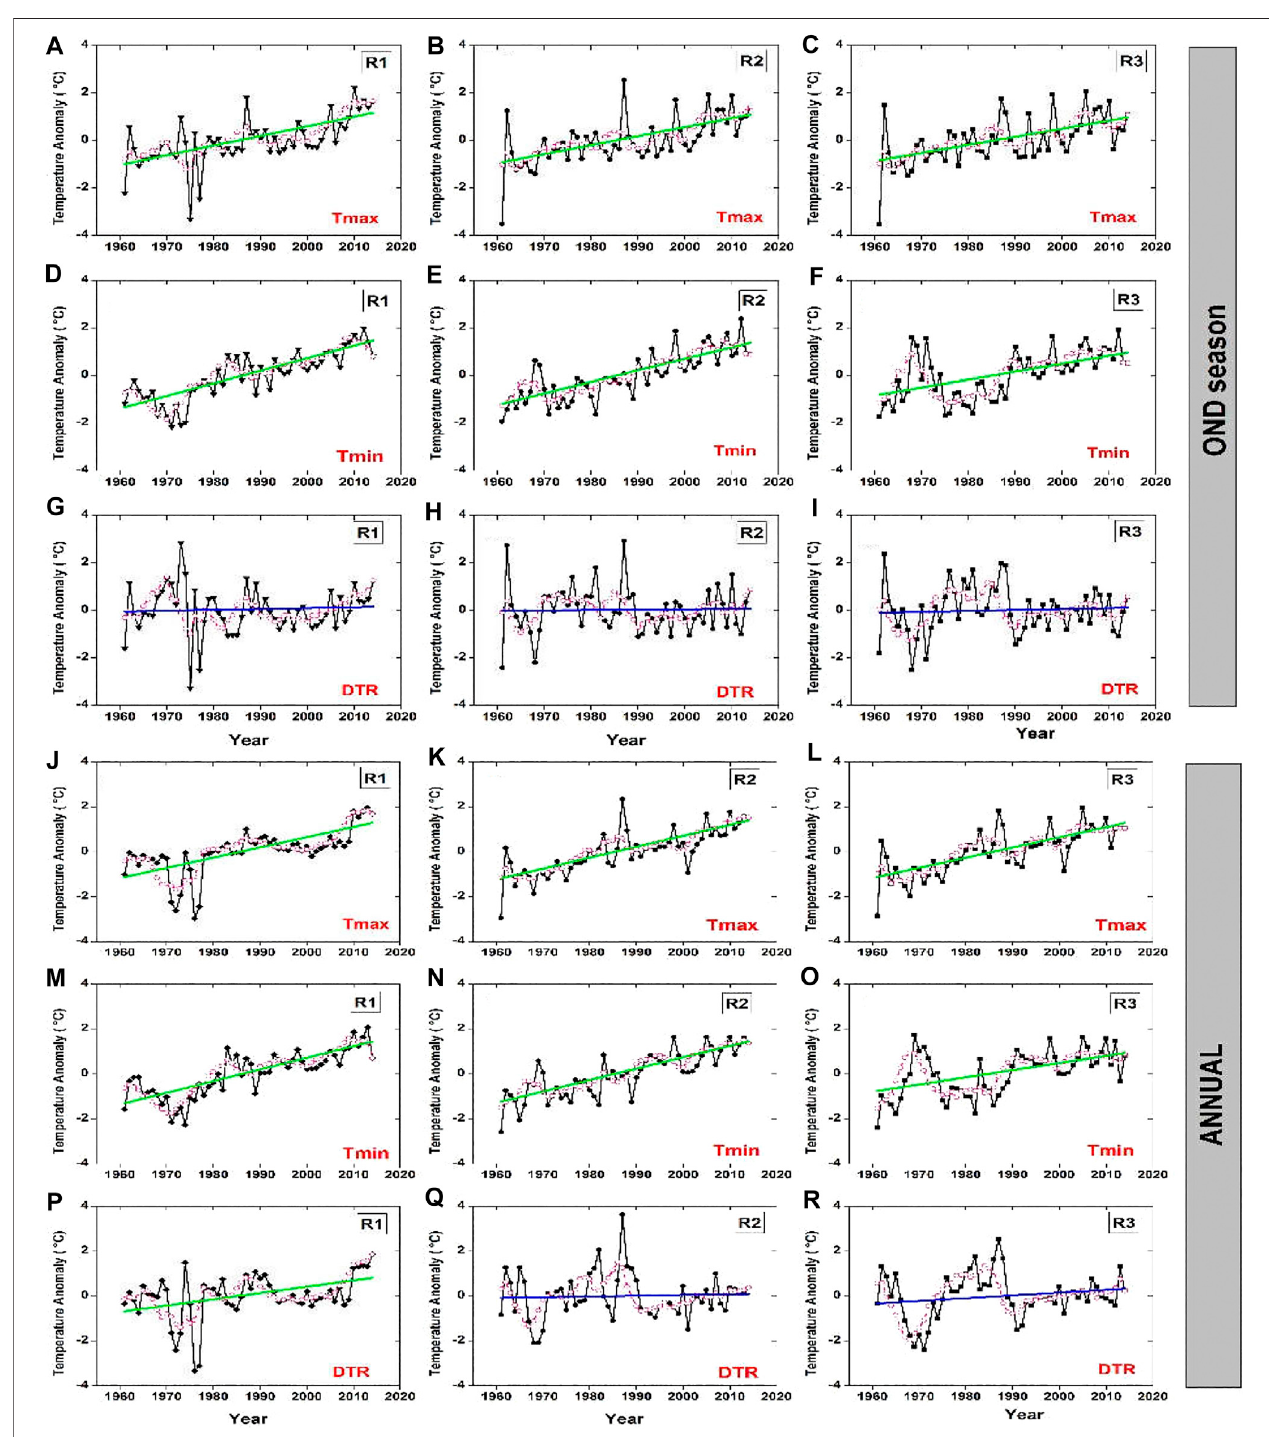
FIGURE 3b | The same analysis for OND and